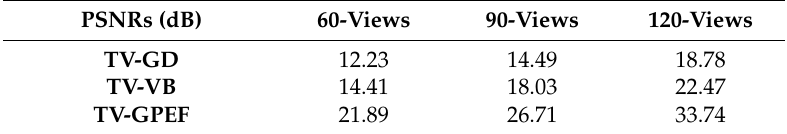
Table 2. PSNR (dB) of the limited-angle circular scanning from the Sheep–Logan phantom.